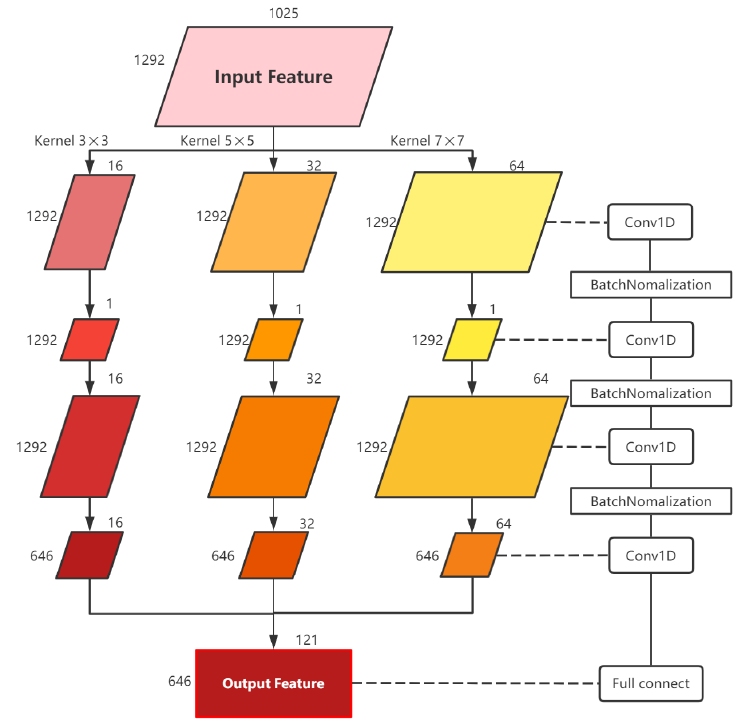
Figure 5. Optimized Inception module.